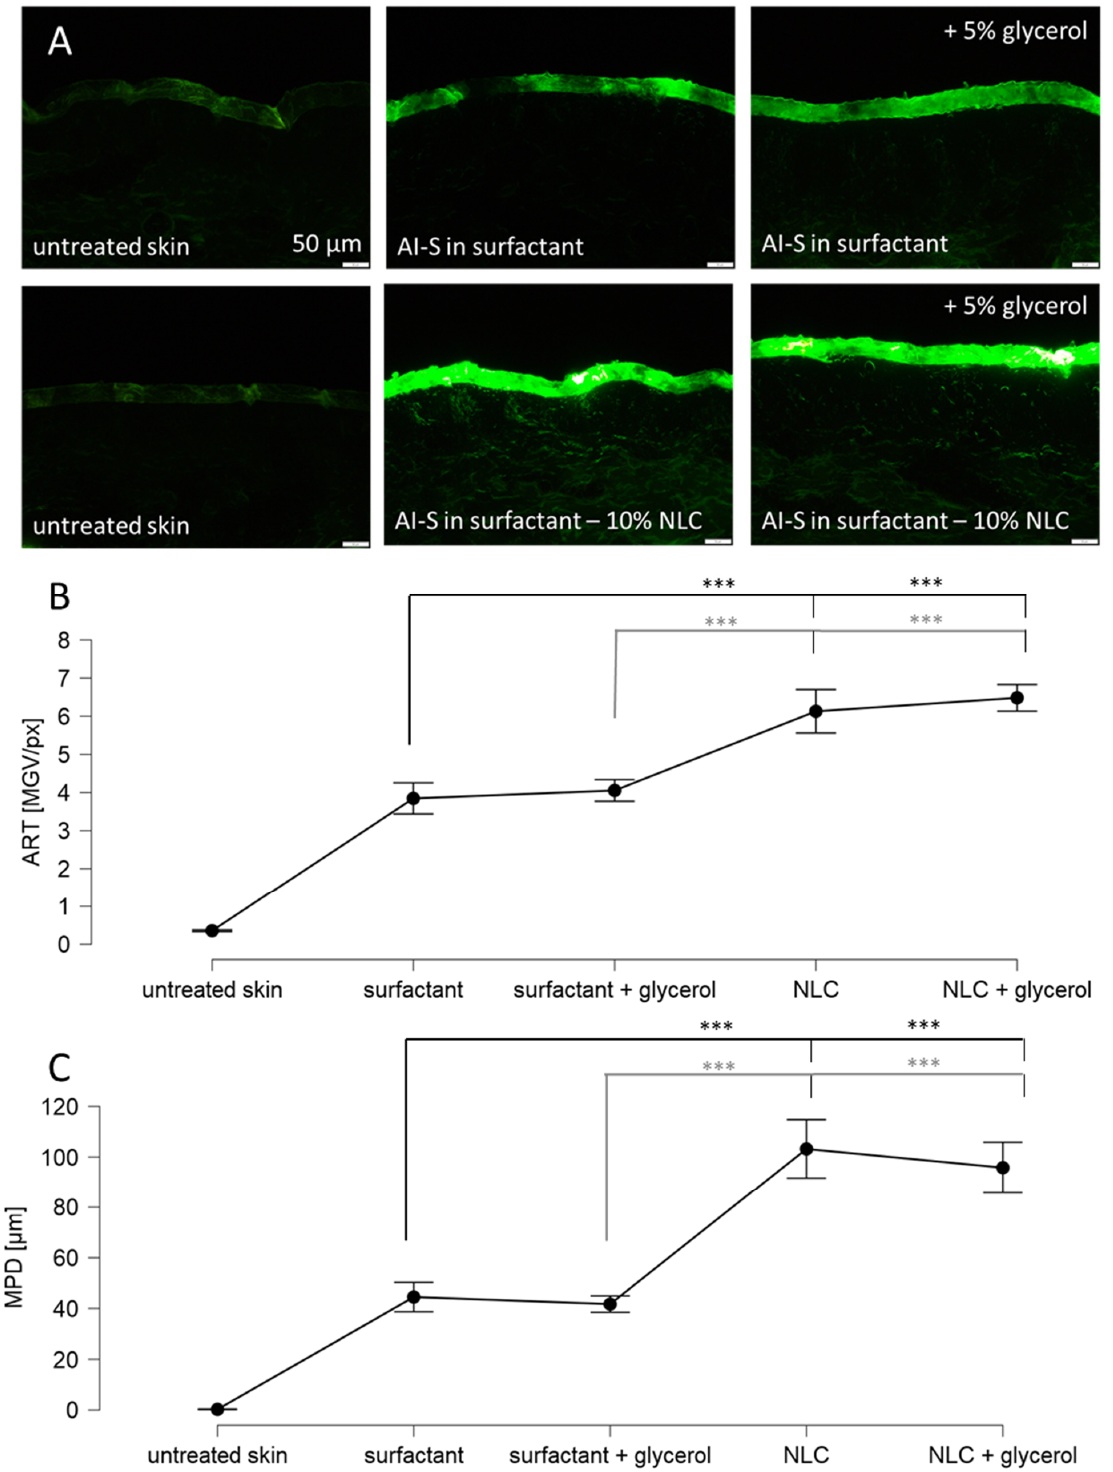
Figure 8. Dermal penetration efficacy of skin treated with sodium fluorescein surfactant solution with and without NLC particles and with and without glycerol. ( A ) Images of vertical skin sections obtained by inverted epifluorescence microscopy, ( B ) ART values as surrogate for the total amount of penetrated AI, ( C ) mean penetration depth (MPD). AI-S = AI surrogate = fluorescein. NLC = nanostructured lipid carriers. Untreated was significant in relation to all measured values. The asterisks indicate the following p -value: *** ≤